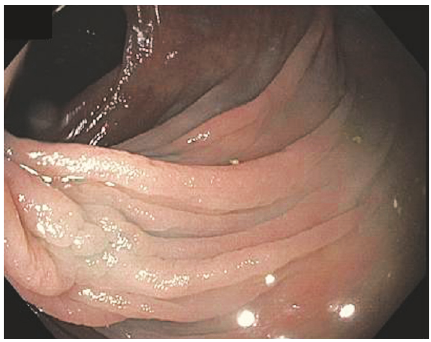
Figure4:Approximatelyeightmonthsaftercoldsnarepolypectomy and treatment with conjugated estrogen/bazedoxifene, no evidence of the nodule remained at the marked site at the hepatic flexure of the